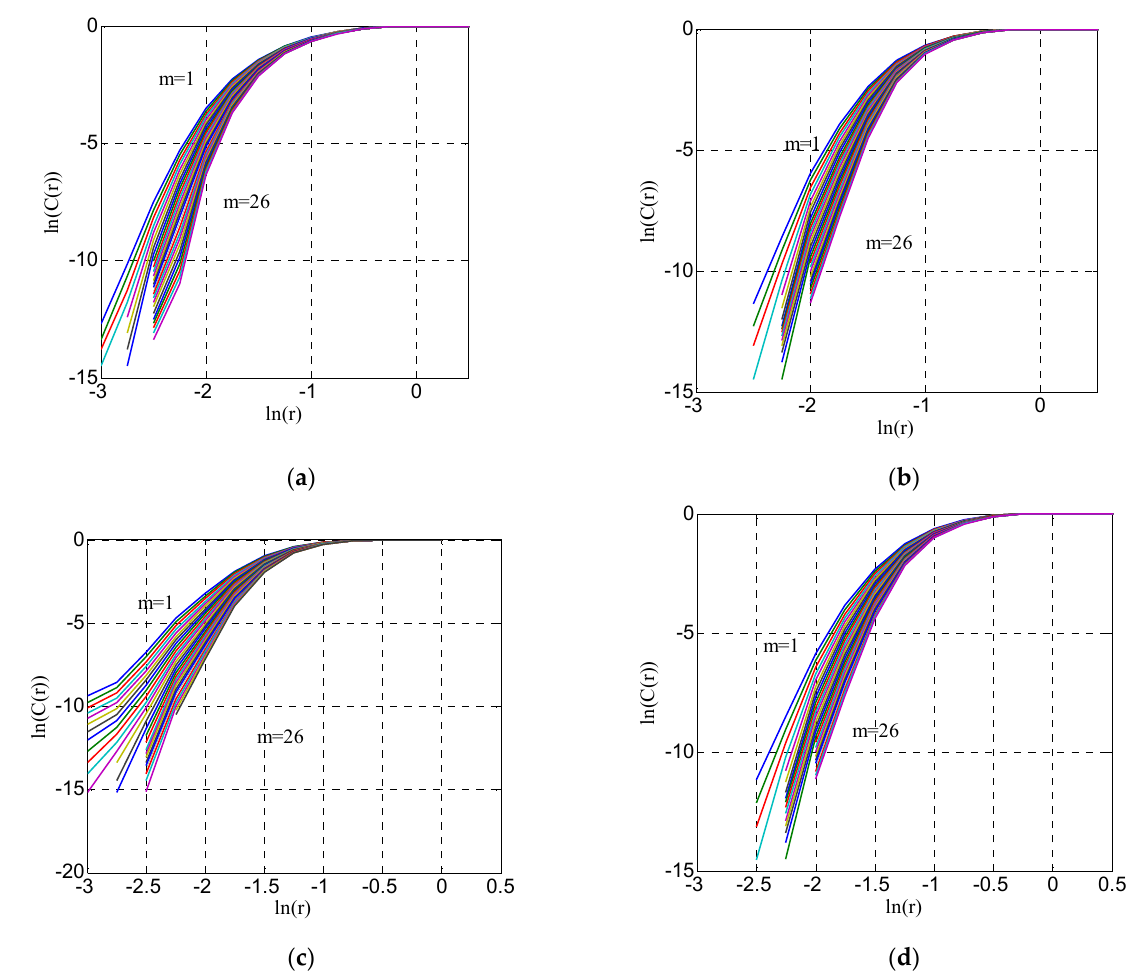
Figure 6. The distribution of lnC m ( r ) versus ln ( r ) calculated by GP theory. ( a ) Unstable spark discharge; ( b ) stable spark discharge; ( c ) stable arc discharge; ( d ) transient arc discharge.